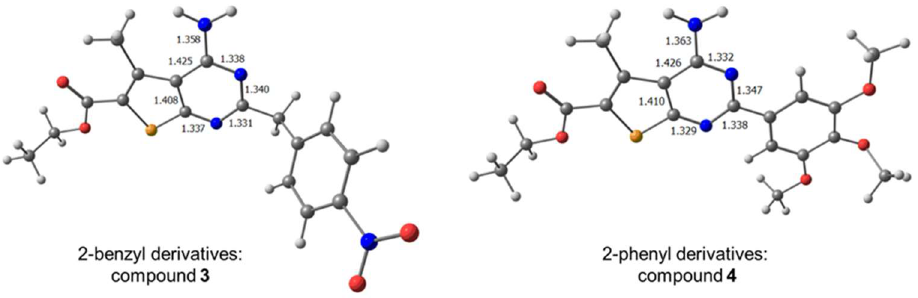
Figure 4. Bond-length alterations in the studied 4-amino-5-methyl-thieno [2,3-d]pyrimidine-6 car- boxylates: 2-benzyl vs. 2-aryl substituted derivatives.